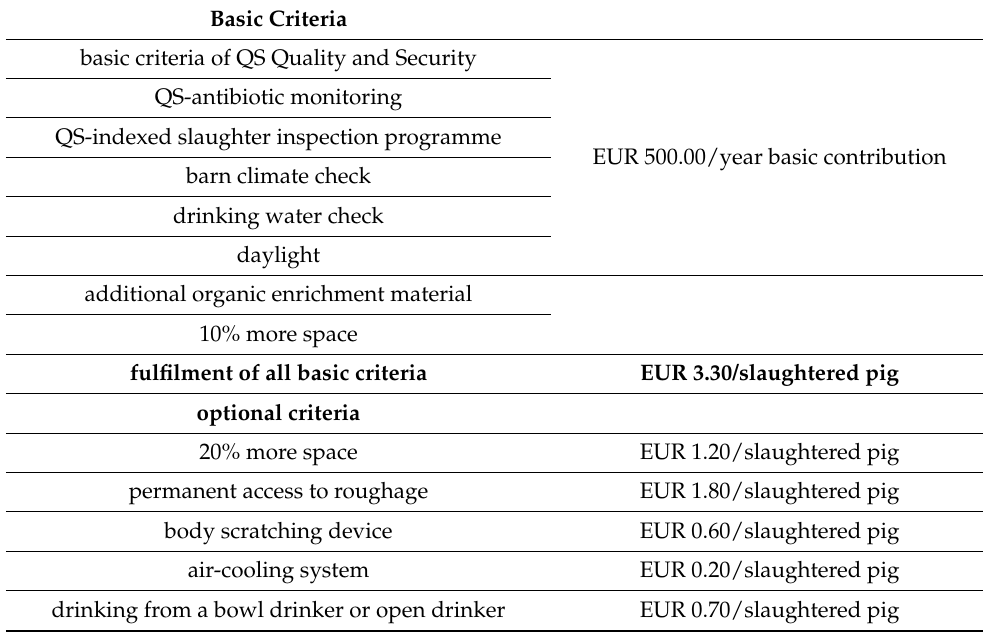
Table 1. Criteria of the animal welfare programme ITW during the second programme phase